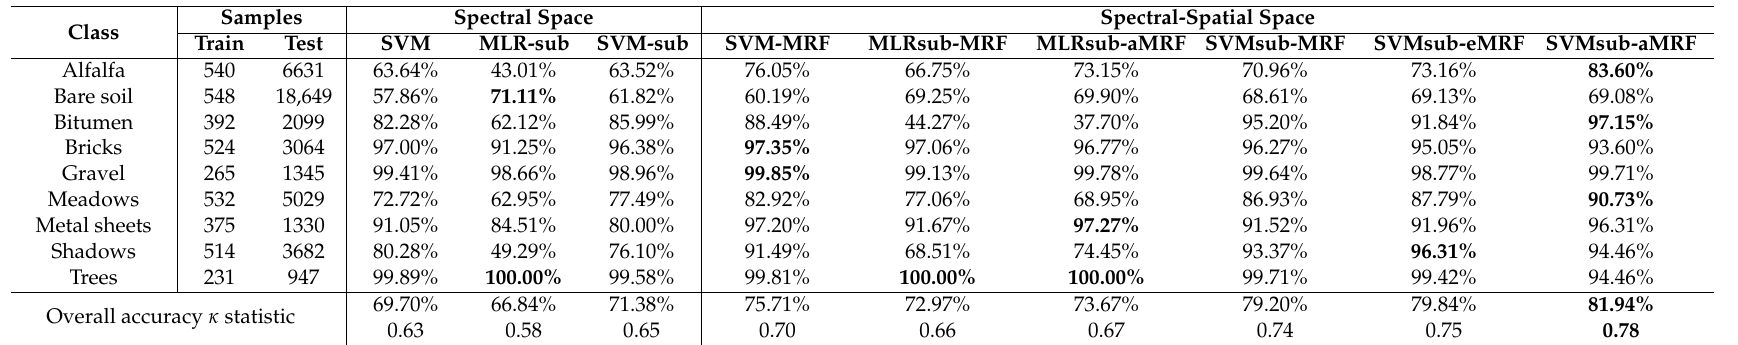
Table 4. Overall, average, and individual class accuracies (in percent) and κ statistic values obtained for the Reflective Optics Spectrographic Imaging System (ROSIS) University of Pavia data set with a training sample size of 20 samples per class. The best results are highlighted in bold